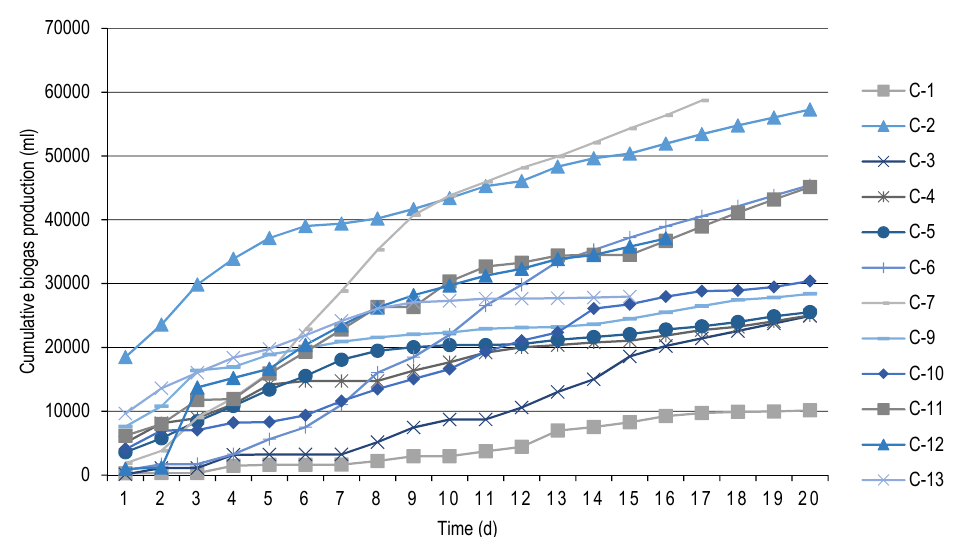
Figure 2. Cumulative biogas production of each combination evaluated. In comparison, combination 1 performed one of the lowest biogas productions, 138.33 mL g − 1 VS during 17 days of stabilization, where the values for the OLR and the nitrogen provider were the same as combination 2 and the C/N value was 25. For all the combinations evaluated in the experimental design, there was a stable performance of the AcoD in terms of its biogas production.